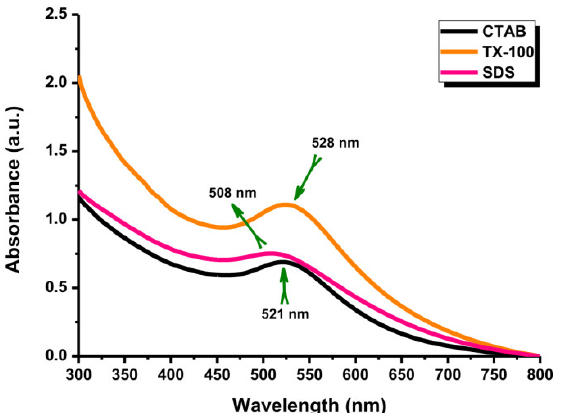
Figure 6. The UV-Vis absorption spectra of Au NPs with different surfactants. Conditions: Surfactant concentration: 10 mM, laser fluence: 0.4 J cm −2 , and ablation time: 200 min.